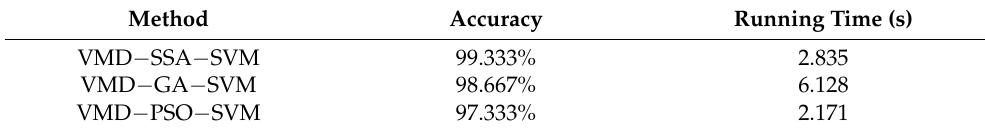
Table 4. Classification accuracy and running time of classification